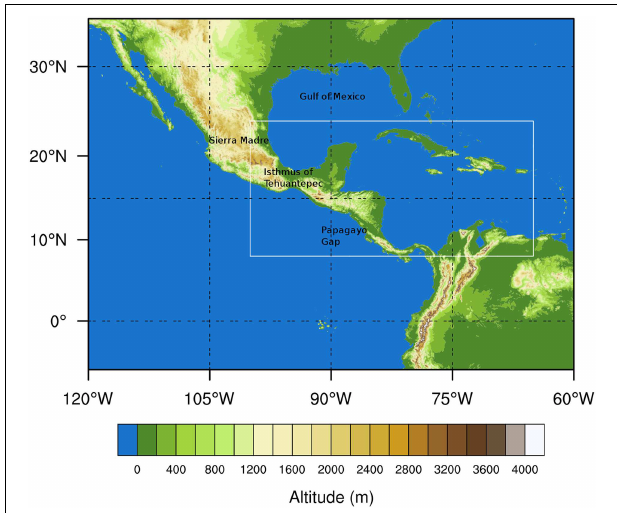
FIGURE 1 | Region of interest. Geographic domain for the ERA-interim data used in the clustering algorithm is enclosed by the white